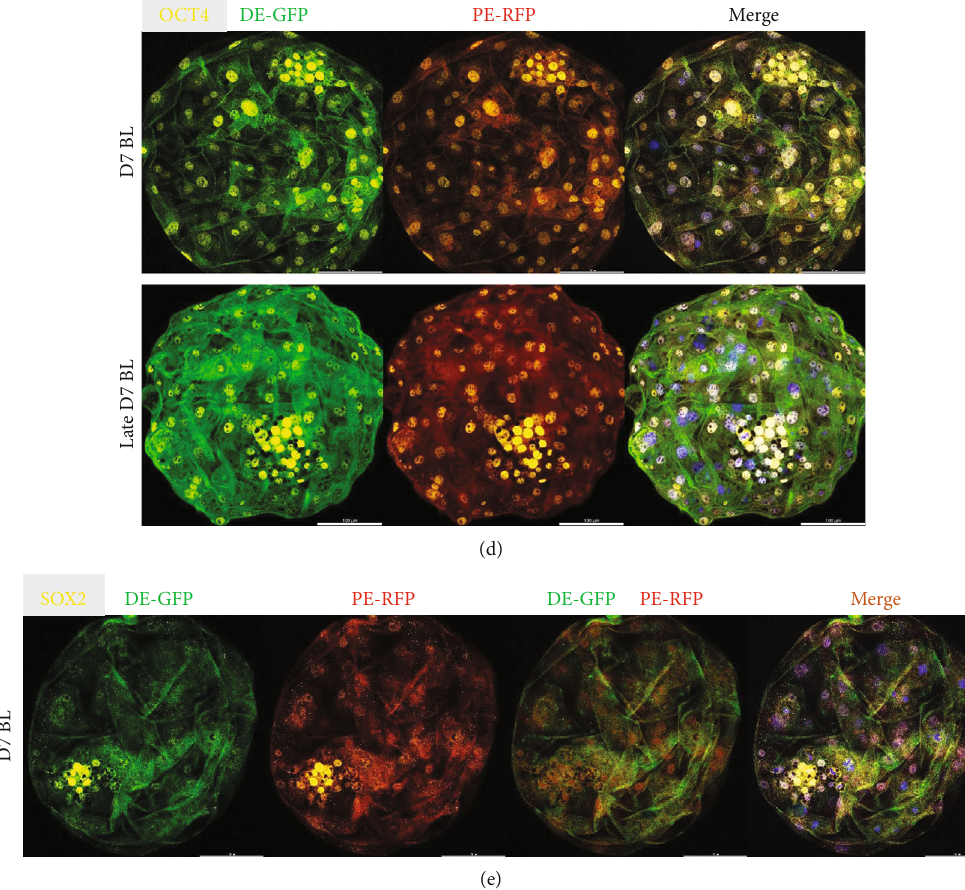
Figure 2: Expression of the OCT4 reporter system during preimplantation porcine embryo development. (a) Expression levels of DE-GFP and PE-GFP were measured in 3 developmental stages (6 – 8 cells, early blastocyst and late blastocyst). Error bars represent the mean SEM. Values with di ff erent letters (a, b, and c) are signi fi cantly di ff erent. (b) Gene expression patterns of PE-GFP and DE-GFP in the OCT4 reporter system-injected embryos. Each group has three replicates. ∗ Signi fi cant di ff erences. ( ∗ p < 0 : 05 , ∗∗ p < 0 : 01 ). (c – e) Immuno fl uorescence analysis for PE-RFP, DE-GFP, pluripotent genes (OCT4 and SOX2 – yellow), and DAPI nuclear staining in OCT4 reporter system-injected embryos. Size maker corresponds to 100 μ